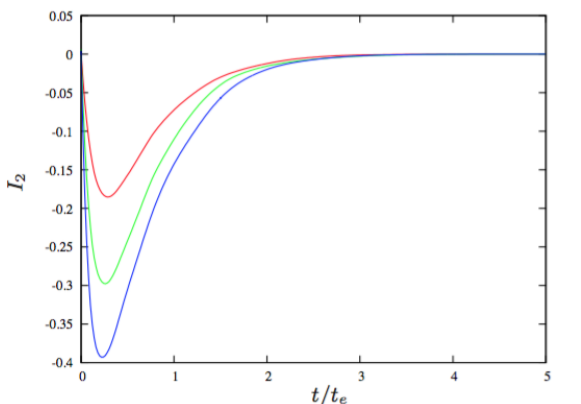
c (cid:48) / K 2 = c (cid:48) / c NO c O 2 NO O 3 3